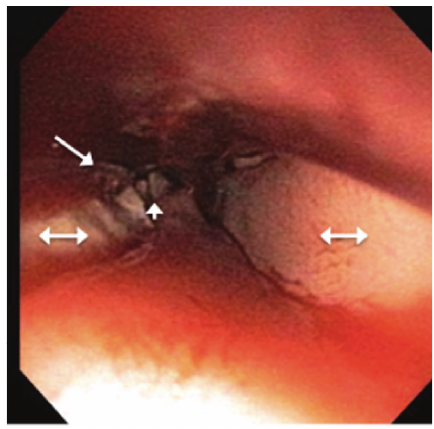
Figure 2: Esophagogastroduodenoscopy (EGD) showing a for- eign body (arrowhead) embedded in the distal esophagus with ulcerations (single-sided arrow) in the surrounding mucosa, with subsequent surrounding edema (double-sided